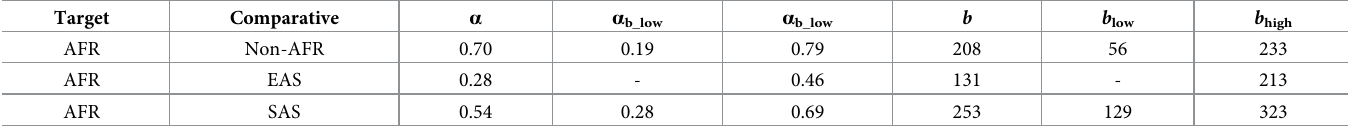
Table 4. Balancing selection in HLA genes. Estimates of the proportion of shared nonsynonymous polymorphisms under balancing selection, α b , and the number of polymorphisms being directly maintained by balancing selection, b , for population comparisons in the HLA region for population comparisons in which Z > 1 when using all genes. Estimates for polymorphisms with frequency > 0.1. Missing values indicate the lower confidence interval was less than 1. Data consist of 177 genes. Code to extract and analyse the data can be found at https://github.com/vivaksoni/test_for_balancing_selection.